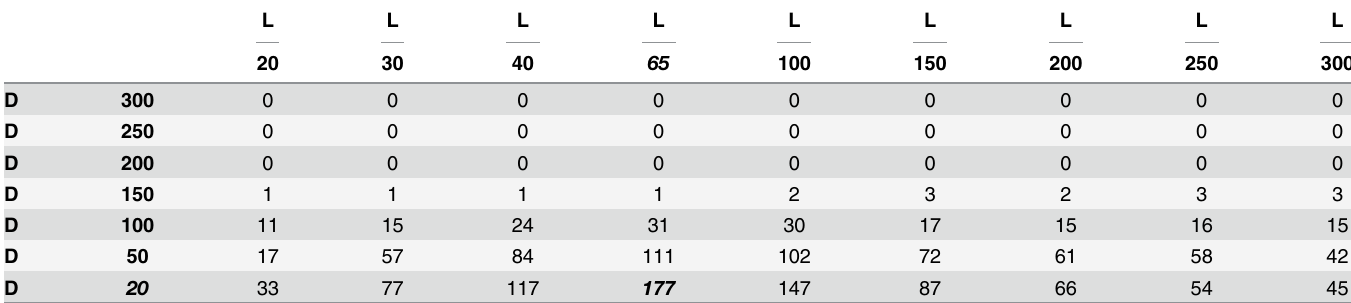
Table 4. Simulation results for a 5,000-ms period at 5,000 photons/s and a threshold of 8. The average values over 6 trials are given. L indicates L window , D indicates D window